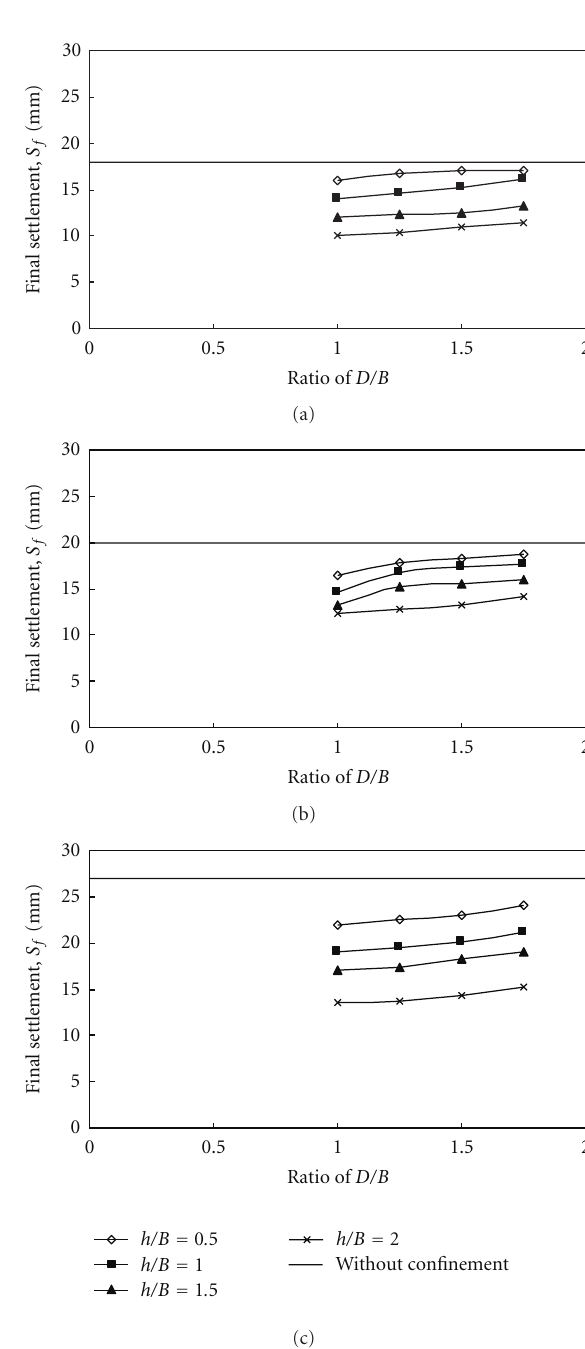
Figure 5: Variation of the final footing settlement with cell geometry at di ff erent